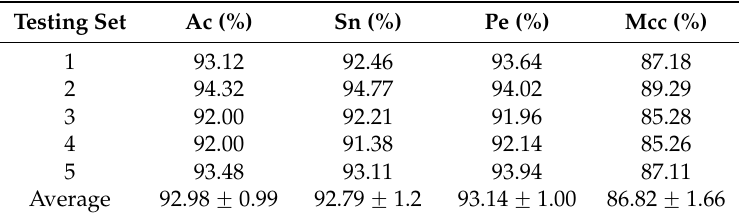
Table 1. Five-fold cross validation results shown using our proposed method on yeast dataset.